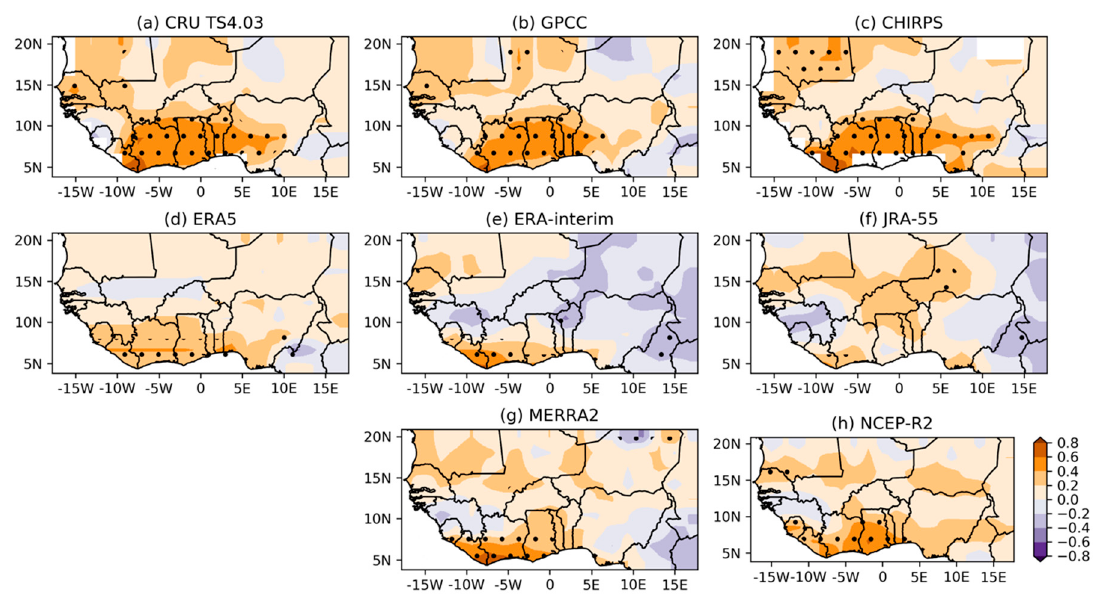
Figure 9. Correlation between Tropical South Atlantic (TSA) SST and mean JJAS precipitation for CRU, GPCC, CHIRPS, and the reanalysis datasets over West Africa. Stippling denotes statistically significant trends at the 5% significance level.